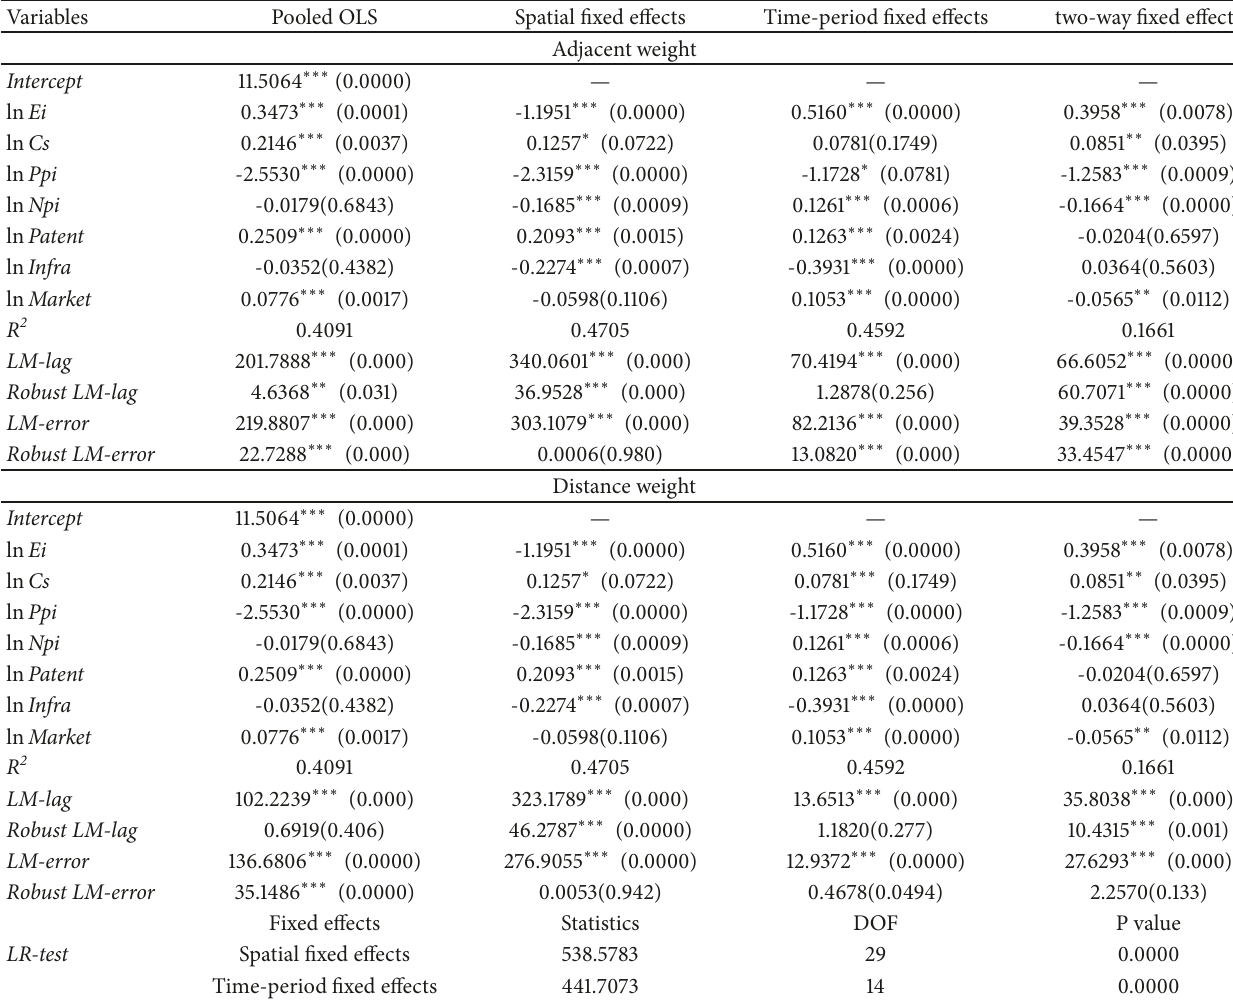
Table 4: Estimation results of nonspatial panel